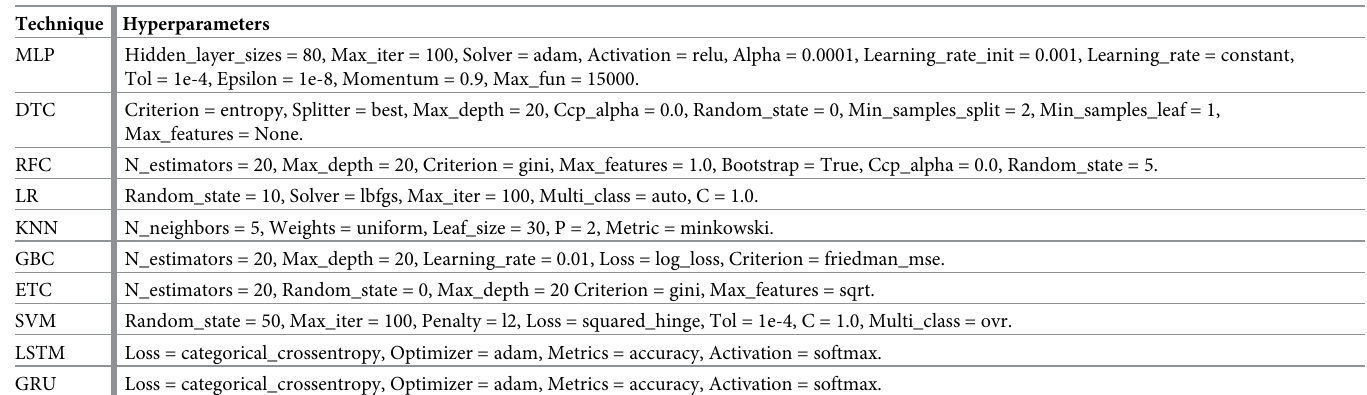
Table 3. The hyperparameters of employed learning techniques. Technique